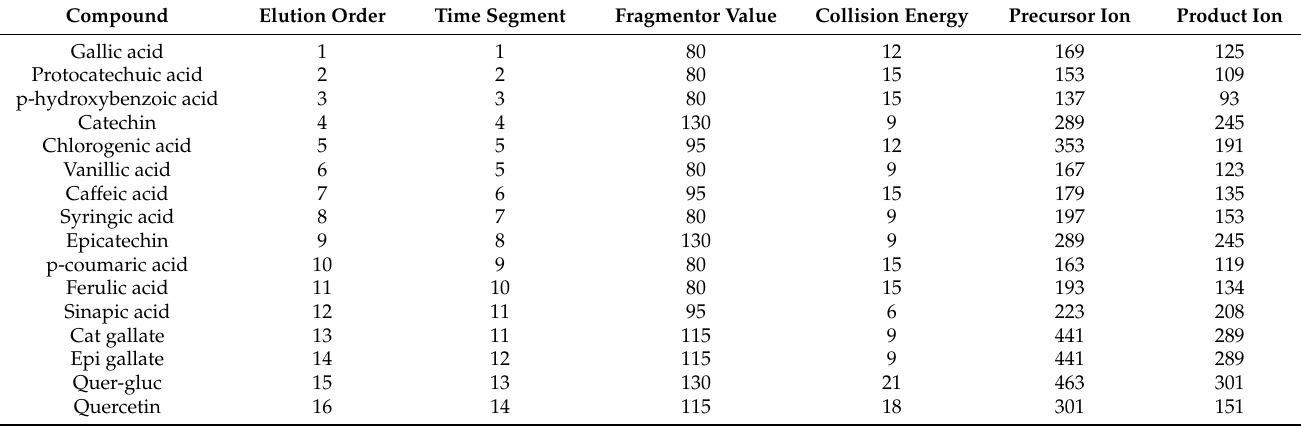
Table A1. Mass spectrometer method energy and m/z values for measured